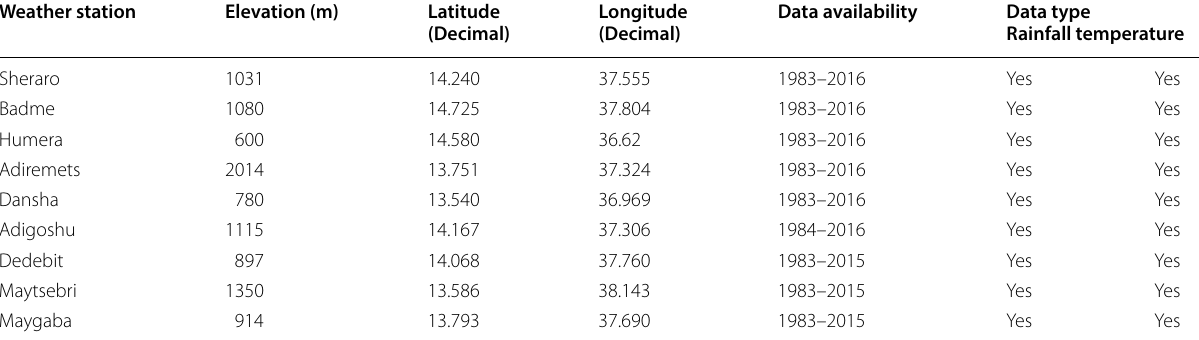
Table 1 Geographical locations, data type, and database availability of nine stations used in the study Weather